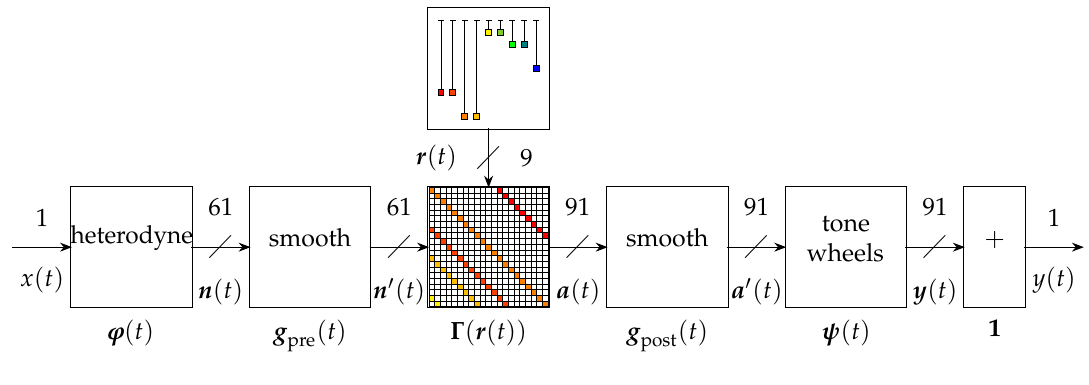
Figure 5. Block diagram of the Hammondizer